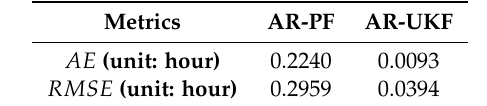
Table 3. Quantitively evaluation results of different models. PF = particle